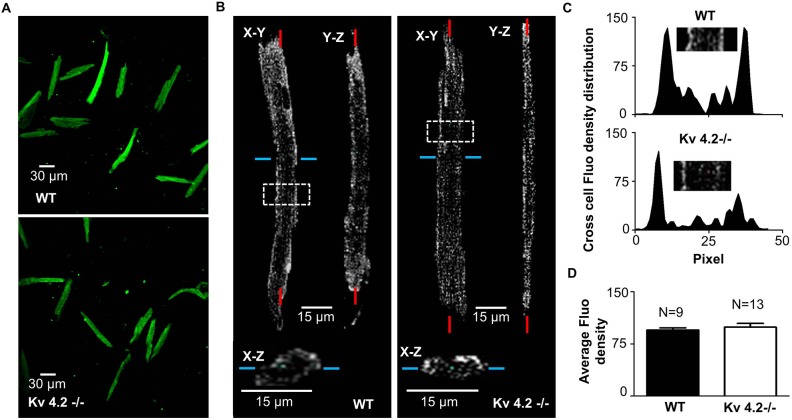
Membrane expression of Kv4.3 subunit in isolated WT and Kv4.2-/- cardiomyocyte.(A) Adult WT (top panel) and Kv4.2-/- (bottom panel) mouse ventricular cardiac myocytes labeled with anti-Kv4.3 antibody show positive fluorescent staining (originating from the 2ndantibody) at 10X magnification. (B) This panel shows the 3D reconstruction of a series of Z-stack fluorescent images of a typical cardiomyocyte taken using a confocal microscope. In the upper part of the figure the fluorescence pattern is shown for cardiomyocytes in two longitudinal orientations (X-Y and Y-Z planes). A cross-section was take through the cardiomyocytes at the position indicated by the blue line and is shown in the bottom (the X-Z plane). The results clearly demonstrate that the fluorescent signals originate primarily from the regions at the periphery for both WT (left panel) and Kv4.2-/- (right panel) cardiomyocytes. (C) This shows the fluorescent density distribution across the WT and a Kv4.2-/- cardiomyocyte shown in Panel B in the regions identified by the white boxes. (D) This quantifies the average integrated fluorescence density for cardiomocytes from WT (n = 9 cardiomyocytes from 4 hearts) and Kv4.2-/- (n = 13 cardiomyocytes from 6 heart) hearts. Average fluorescent density was calculated by summing the total fluorescent signal intensity normalized for the total number of pixels for each cardiomyocyte. Note this quantifies and the Kv4.3-subunit expression level in each cardiomyocyte.